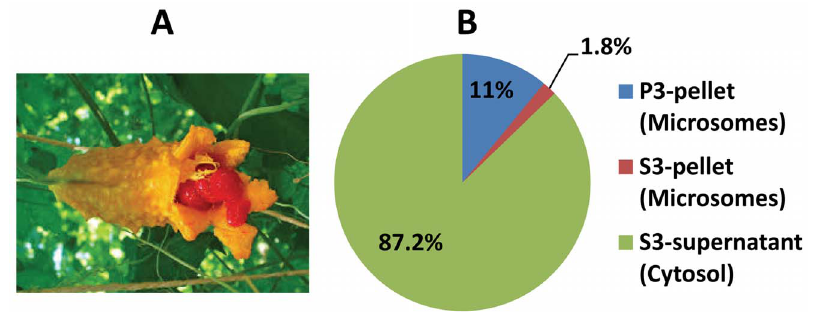
Figure 2. Subcellualr distribution of PAP activity in bitter melon cotyledons. (A) bitter melon of Indian origin was used in the study. (B) Distribution of PAP activity in bitter mellow cotyledons. The cotyledon extract was successively centrifuged at 3,000 g , 18,000 g and 105,000 g . The final pellet (P3-pellet) after ultracentrifugation is generally regarded as the microsomal membranes. Following dialysis and centrifugation of the 105,000 g supernatant, the S3-pellet (contaminated microsomes) and the S3-supernatant (cytosol) were obtained. All three fractions were analyzed for PAP activity. The data presented are the mean of 2 assays for each sample.